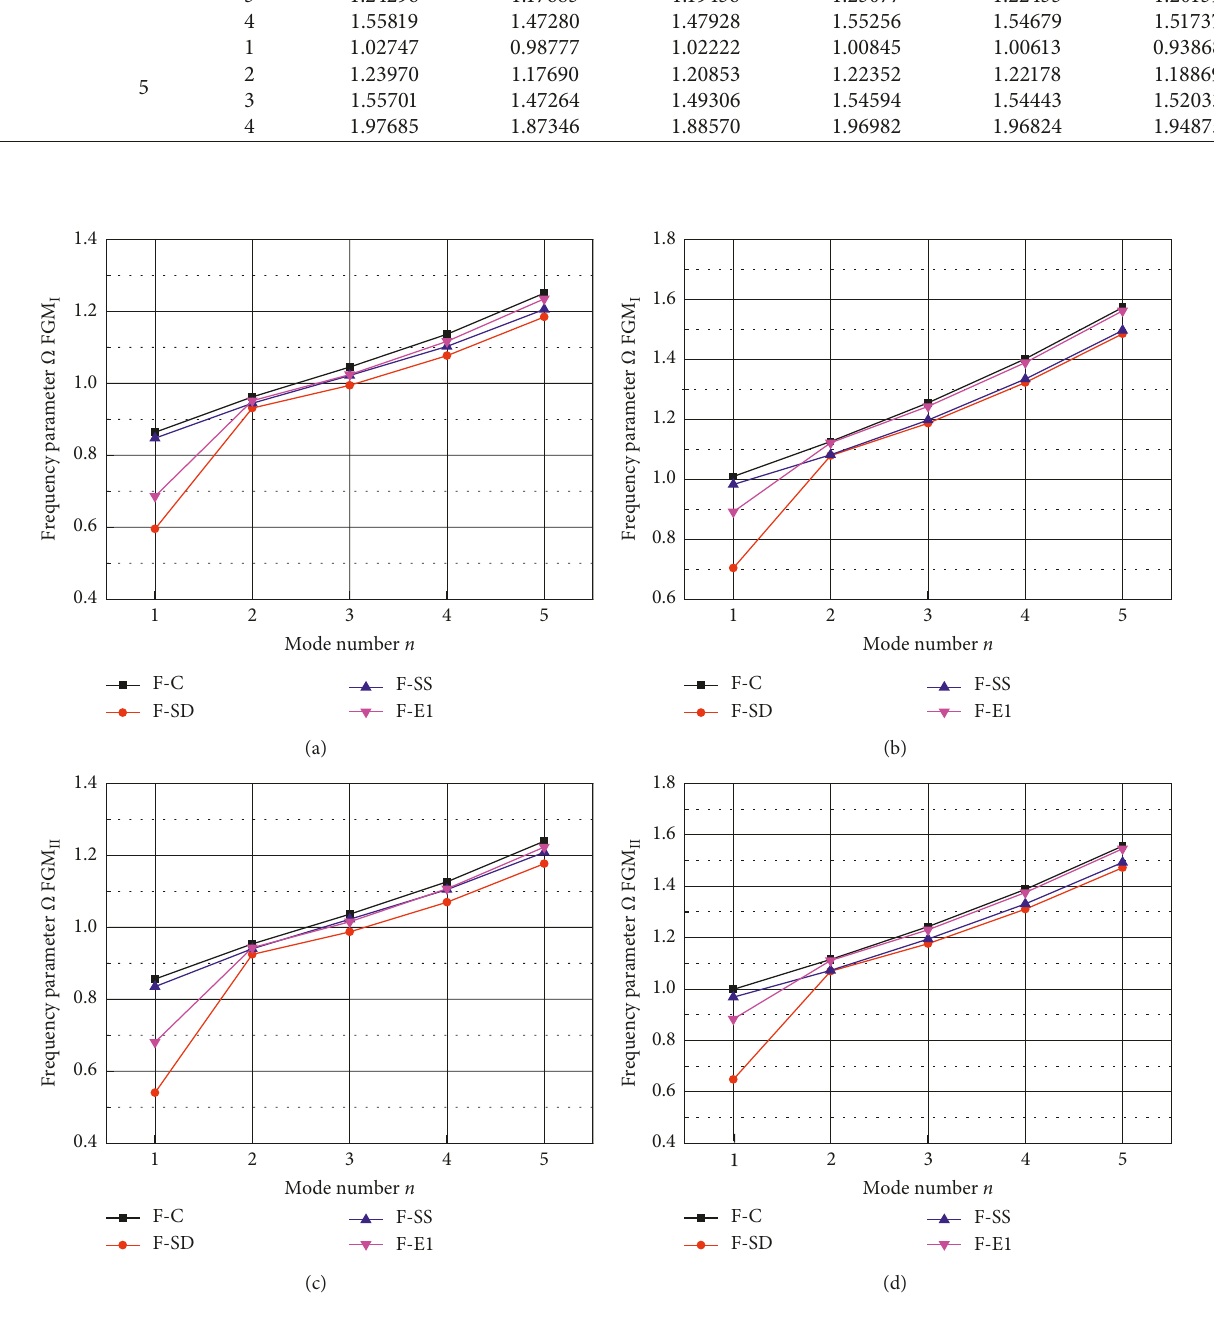
Figure 10: Frequency parameters Ω of FG spherical shell with different boundary